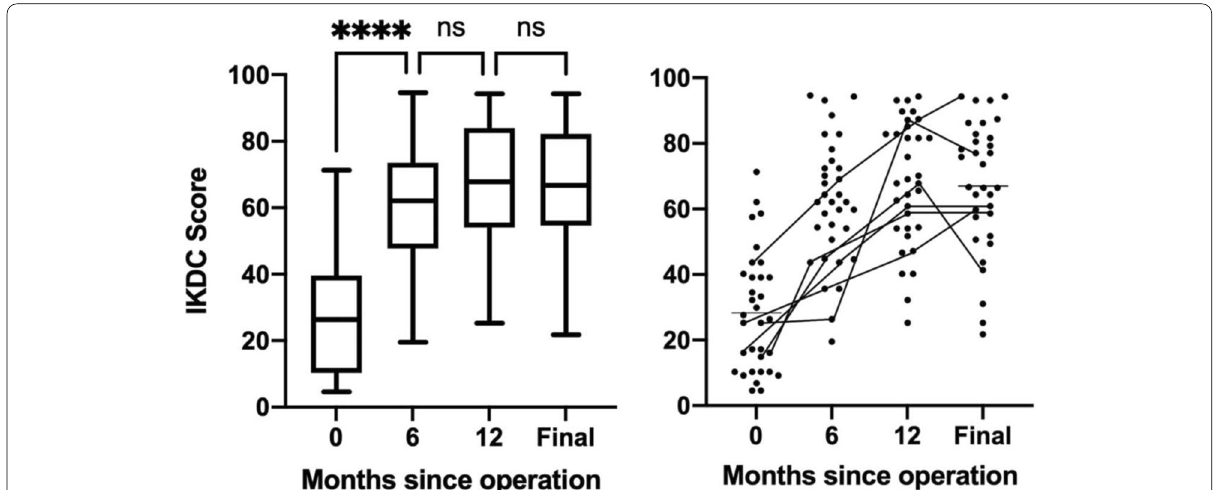
Fig. 2 Progression of IKDC scores overtime following root repair ( n 33). Scores are presented pre-operatively at 0 months and at post-operative = intervals of 6 months, 12 months and mean final follow-up of 39.4 months. Individual trajectories are outlined for the six participants who reported delayed improvements of at least 15 points between 6 and 12